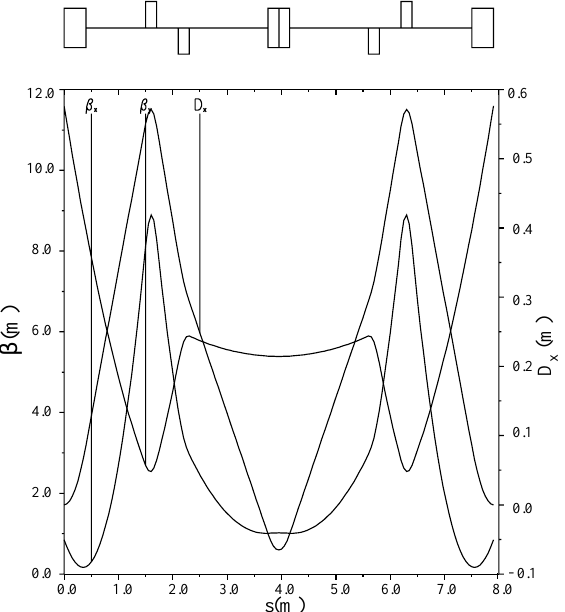
FIG. 4. Optical functions for R 56 (cid:1) 0 m.